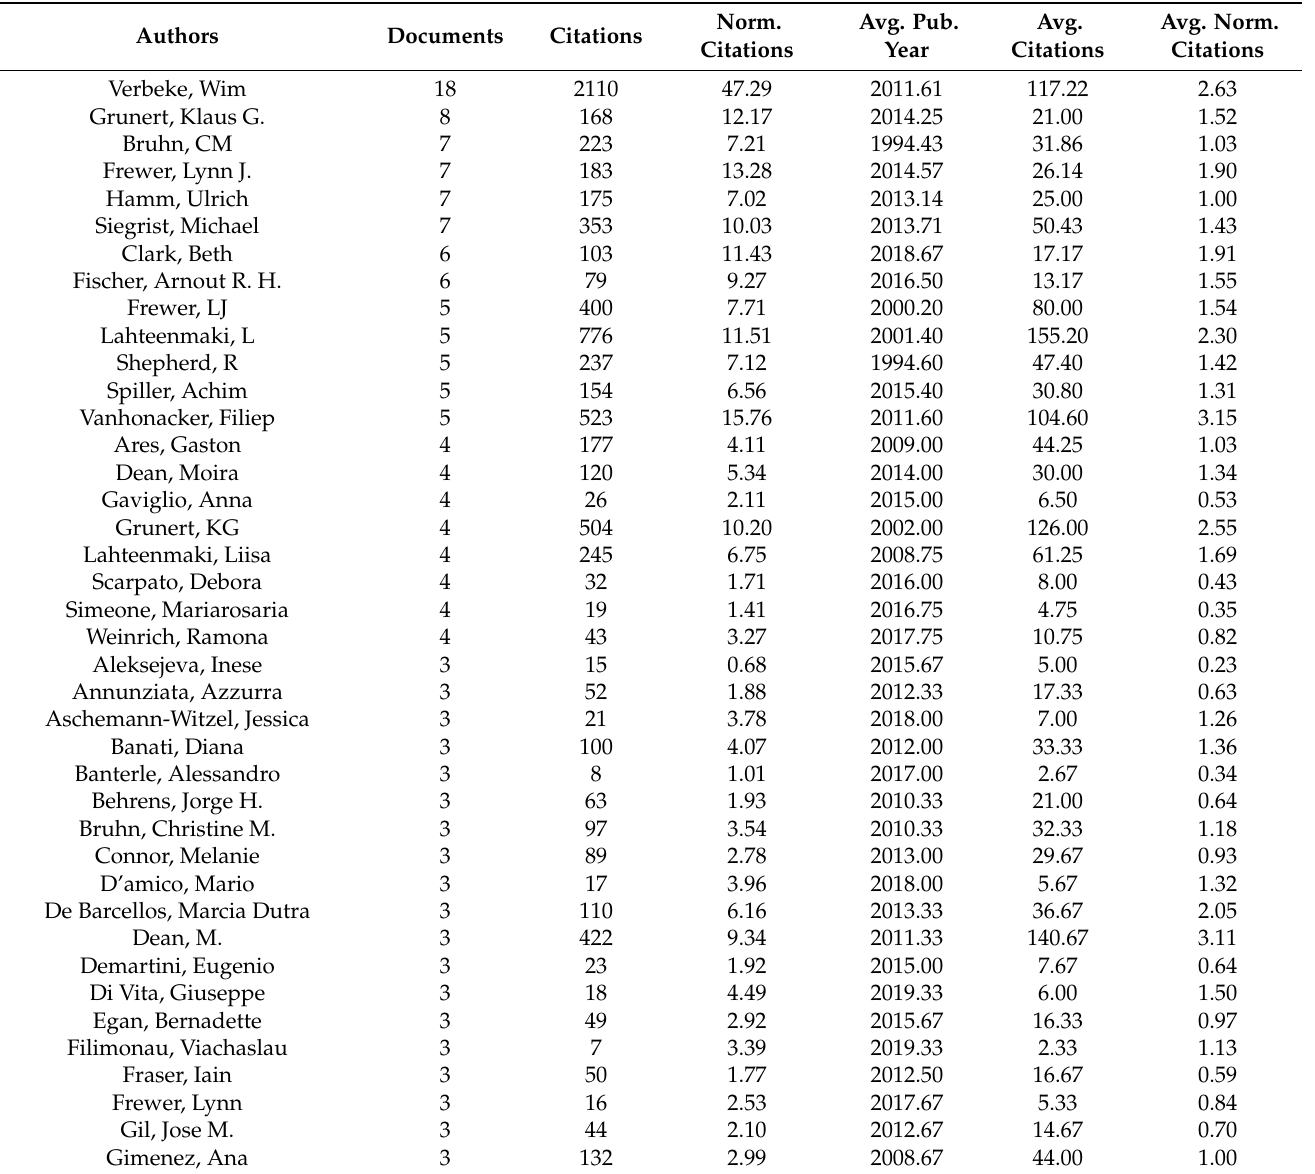
Table A3. Bibliometric information for the authors with more documents (top 40).